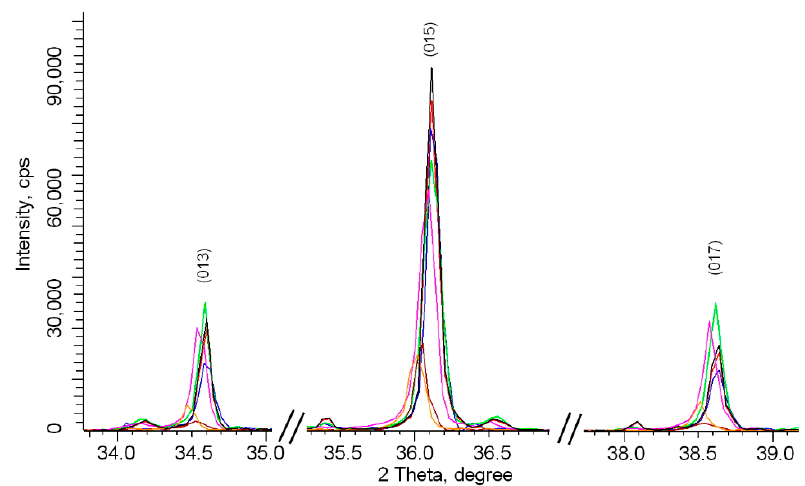
Figure 3. Detailed representation of changes in diffraction reflections in the range of 2 θ = 33–45°: black line—Initial sample; red line—10 15 ion/cm 2 ; blue line—10 16 ion/cm 2 ; green line—5 × 10 16 ion/cm 2 ; magenta line—10 17 ion/cm 2 ; yellow line—3 × 10 17 ion/cm 2 ; brown line—5 × 10 17 ion/cm 2 .